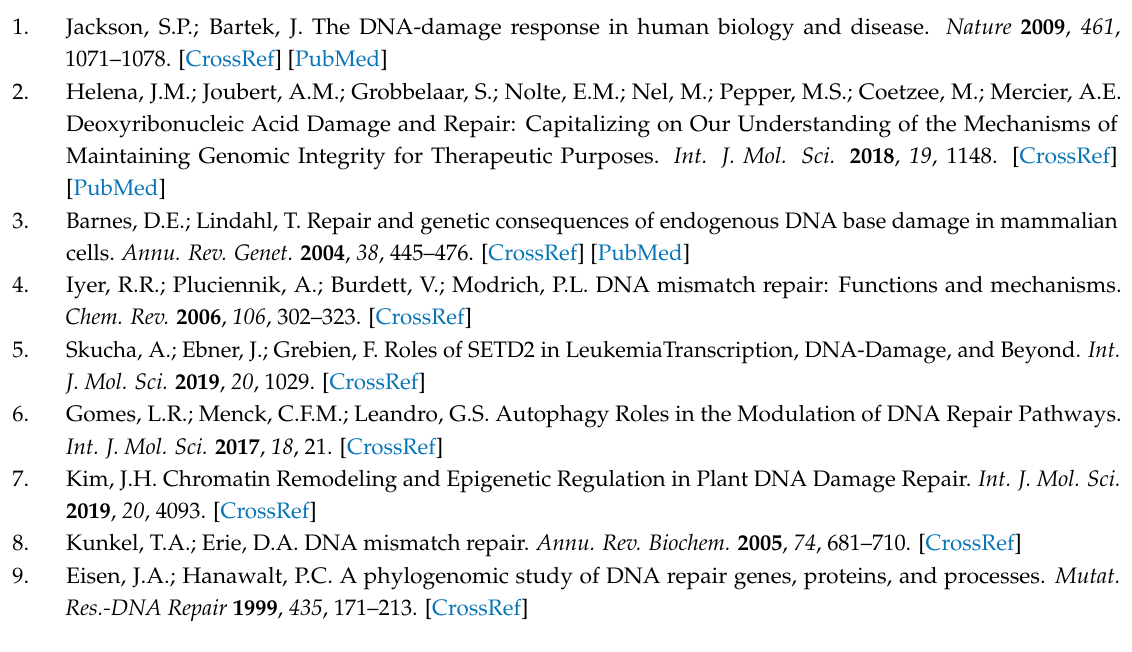
s1, Figure S1: Interaction spectra between EndoMS/NucS and the mismatched dsDNA. Figure S2: Decomposition of binding free energy, on a per-residue basis, into contributions from the sum of electrostatic interactions and polar solvation energy, the van der Waals energy, and nonpolar solvation energy for the key residues of C-terminal domains of M20. Figure S3: The distance of two Mg 2 + ions to the mismatched dsDNA: (a) Mg 2 + , and (b) Mg’ 2 + . (c) The binding site of Mg 2 + . (d) The binding site of Mg’ 2 + . Table S1: The binding energy contributions of the key residues of M1 and M20. Table S2: Hydrogen bonds between EndoMS/NucS and dsDNA of the C-terminal domains of M20 in the last 20 ns. Table S3: Twenty models from the open state (M1) to the closed state